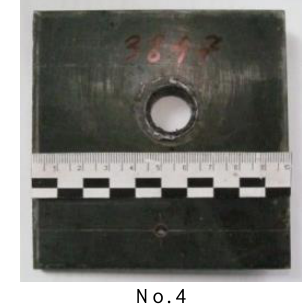
Fig 7. Samples after impact in the second series of